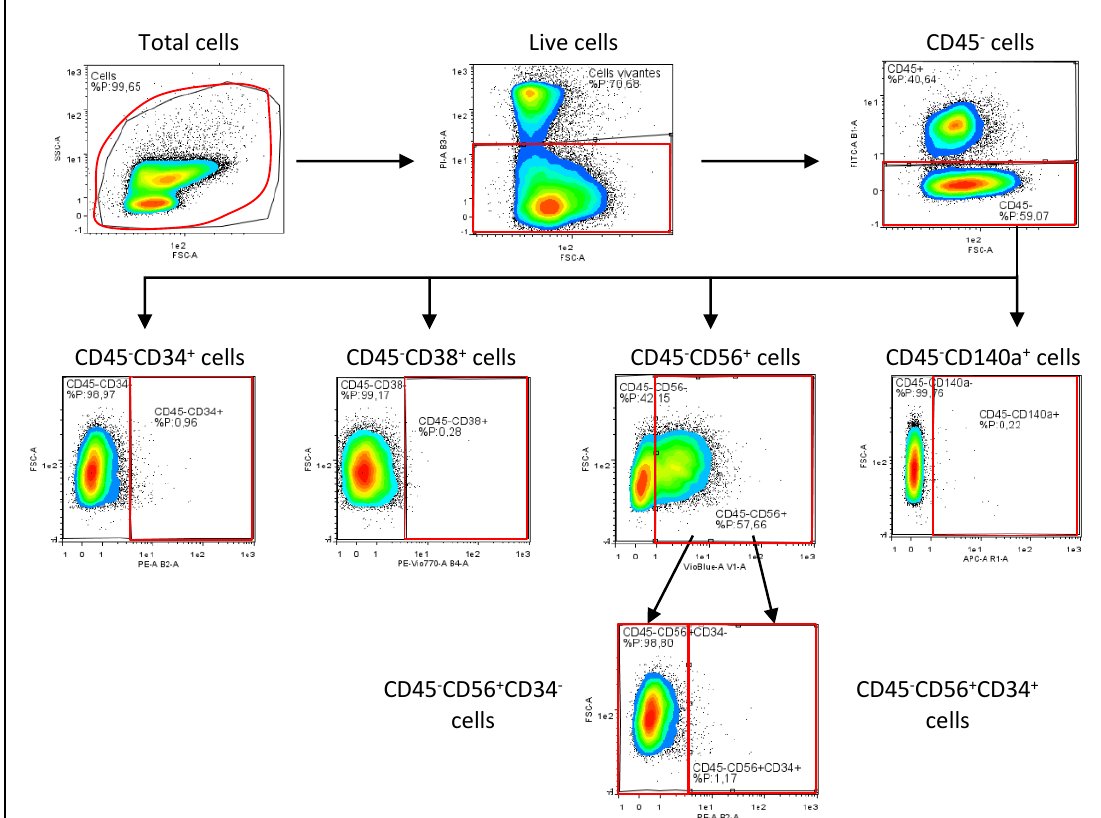
Figure 2. Representative flow cytometry plots illustrating the immunophenotyping strategy used for mesenchymal stromal/stem cells isolated from adipose subcutaneous tissue of growing pigs. The captions correspond to the cell populations highlighted in red. In addition, the red boxes delimit the positivity threshold of studied cell populations established according to the appropriate isotype and Fluorescence Minus One